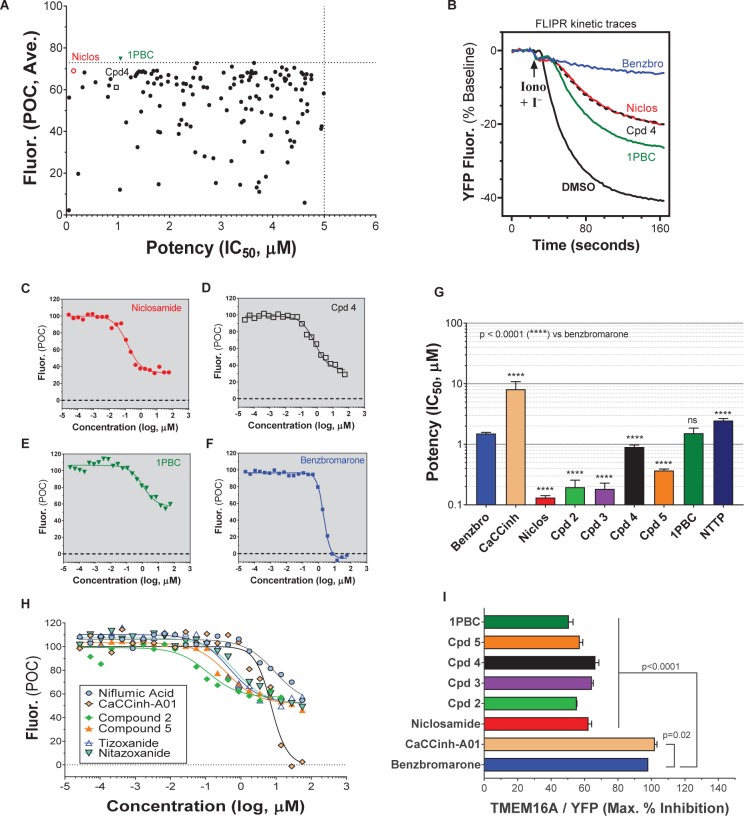
High-throughput screen using a halide-sensitive YFP assay identifies niclosamide as a highly potent, nanomolar inhibitor of TMEM16A. (A) Potency range of the 145 hits from the TMEM16A high-throughput screen and triplicate hit confirmation at 5 μM (n of 4) that reduced the YFP quenching by less than 72.6 percent of control (POC) response to ionomycin (Iono)/iodide alone. The dotted horizontal and vertical lines demarcate the cut-off values (POC < 72.6, IC50 < 5 μM) for validated hits. Representative data from the medchem TMEM16A YFP assay showing FLIPR kinetic traces for the DMSO vehicle control or compounds at 55.6 μM (B), and dose-response curves indicating niclosamide (C), Cpd 4 (D) and 1PBC (E) only partially blocked the ionomycin-induced YFP response, while benzbromarone (F) and CaCCinh-A01 (H) gave full block. Niclosamide and related compounds, Cpd 2 – Cpd 5, were more potent TMEM16A antagonists than benchmarks (G,H), but only partially blocked the iodide/YFP response (I). Nitazoxanide and tizoxanide were identified as additional inhibitors of TMEM16A (H). Mean ± SEM, n of 3–58. ∗∗∗∗P < 0.0001; significant difference from the benzbromarone benchmark antagonist; ns, not significant (unpaired t-test).